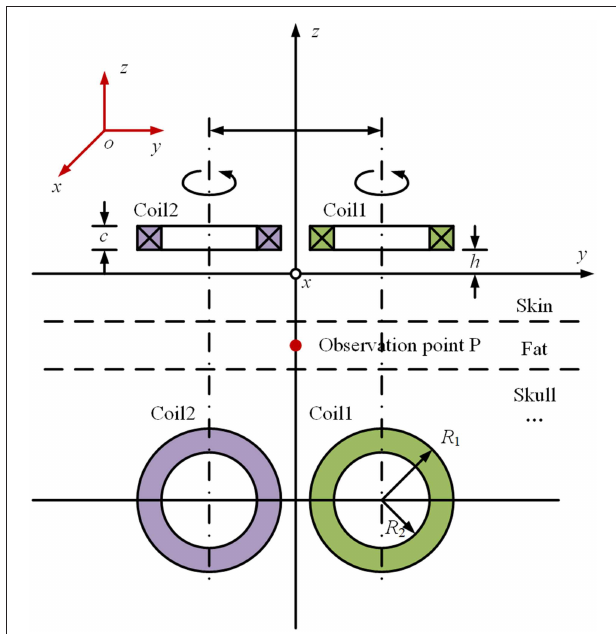
FIGURE 2 | Schematic diagram of the coordinate system of “figure-of-eight coil”.